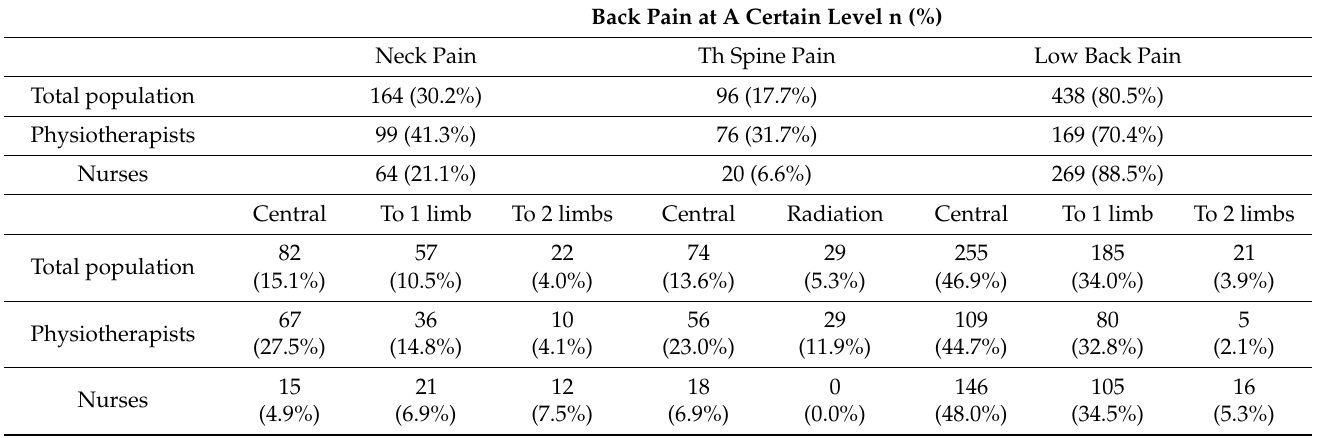
Table 2. Back pain prevalence rates based on